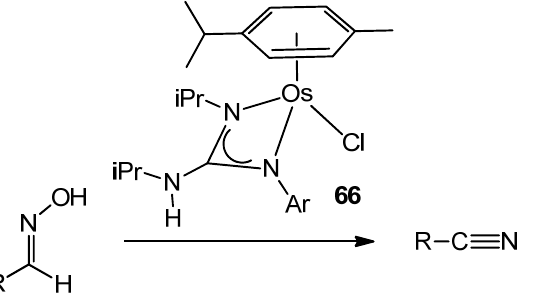
Figure 39. Osmium guanidinato complexes acting as aldoxime dehydration catalysts.